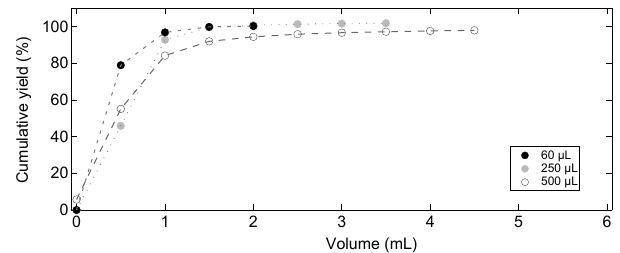
Figure 3. Elution curves indicating cumulative yield of boron for different volumes of the boron-specific resin (Amberlite IRA 743) used in the ion exchange column.